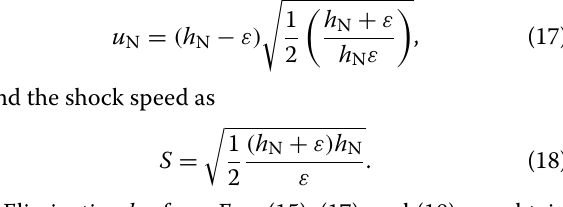
from Eq. (14). The equation provides the relationship between h = h N and u = u N inside the current.